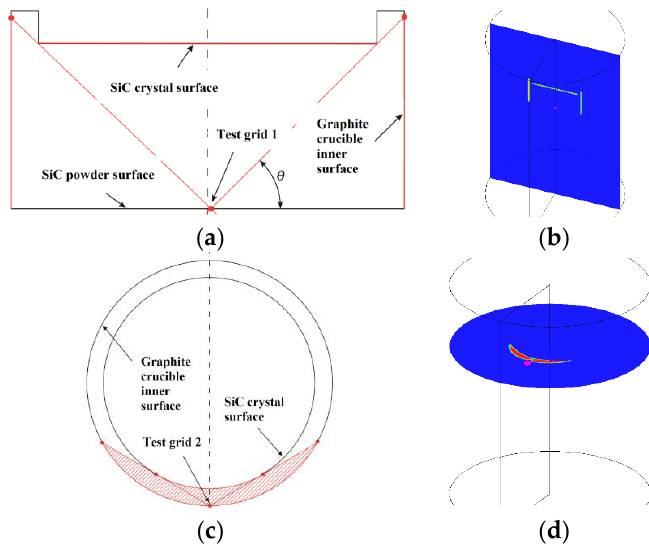
Figure 3. Visible regions of grids located on growth chamber. ( a ) Grid 1 on SiC powder surface; ( b ) calculated visible region for grid 1; ( c ) grid 2 on graphite crucible inner surface; ( d ) calculated visible region for grid 2.